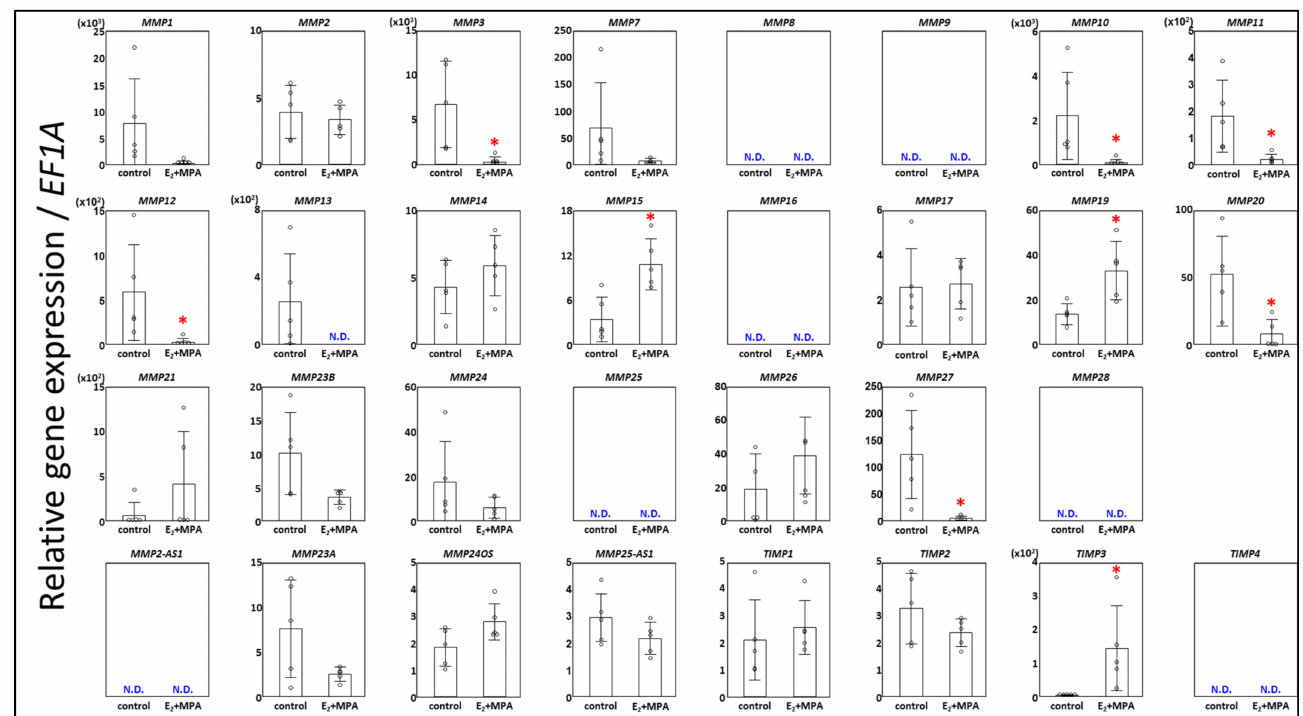
Figure 1. Effect of E 2 + MPA treatment on MMPs or TIMPs in human endometrial stromal cells. Human endometrial stromal cells were treated with E 2 (10 − 8 mol/L) + MPA (10 − 7 mol/L) (E 2 + MPA) or without hormonal treatment (control) for 12 days. The expression levels of all protein-coding MMPs, TIMPs, and long non-coding antisense RNAs from MMP loci were analyzed by quantitative RT-PCR. MMP and TIMP RNA levels were normalized to those of EF1A. Values are shown as mean fold change ± SD of independent experiments using cells derived from different patients ( n = 5). Each dot indicates the value for different cell preparations. An asterisk indicates statistically significant differences from the control group, * p <